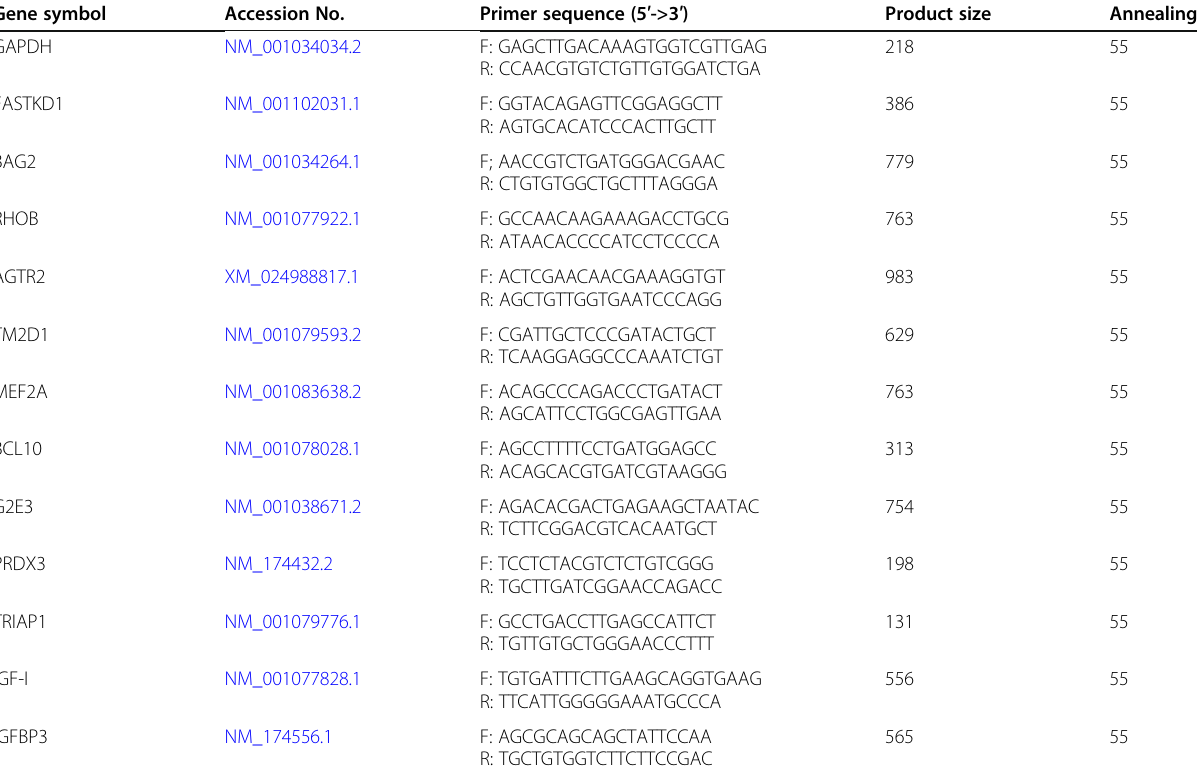
Table 1 Primer sequences Gene symbol